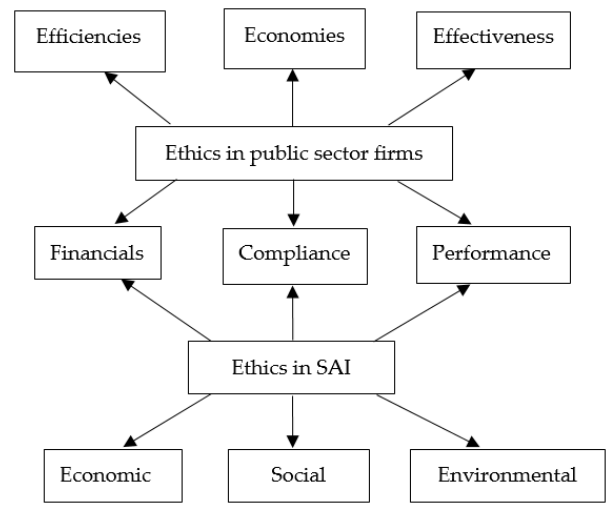
Figure 4. Expanding value for money audits in the public sector.